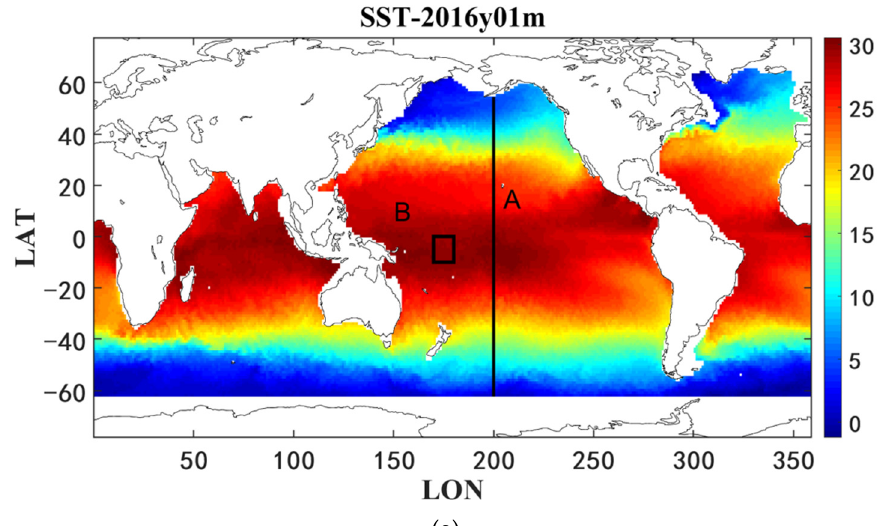
Figure 8. The spatial distribution of DORS, LightGBM, and Argo at 2000 m for January 2016, and intensity scatter plots: ( a ) is the LightGBM ST, ( b ) is the DORS ST, ( c ) is the intensity scatter plots between the LightGBM ST and the EN4-Profile ST, ( d ) is the Argo ST, and ( e ) is the intensity scatter plots between the DORS ST and the EN4-Profile ST.